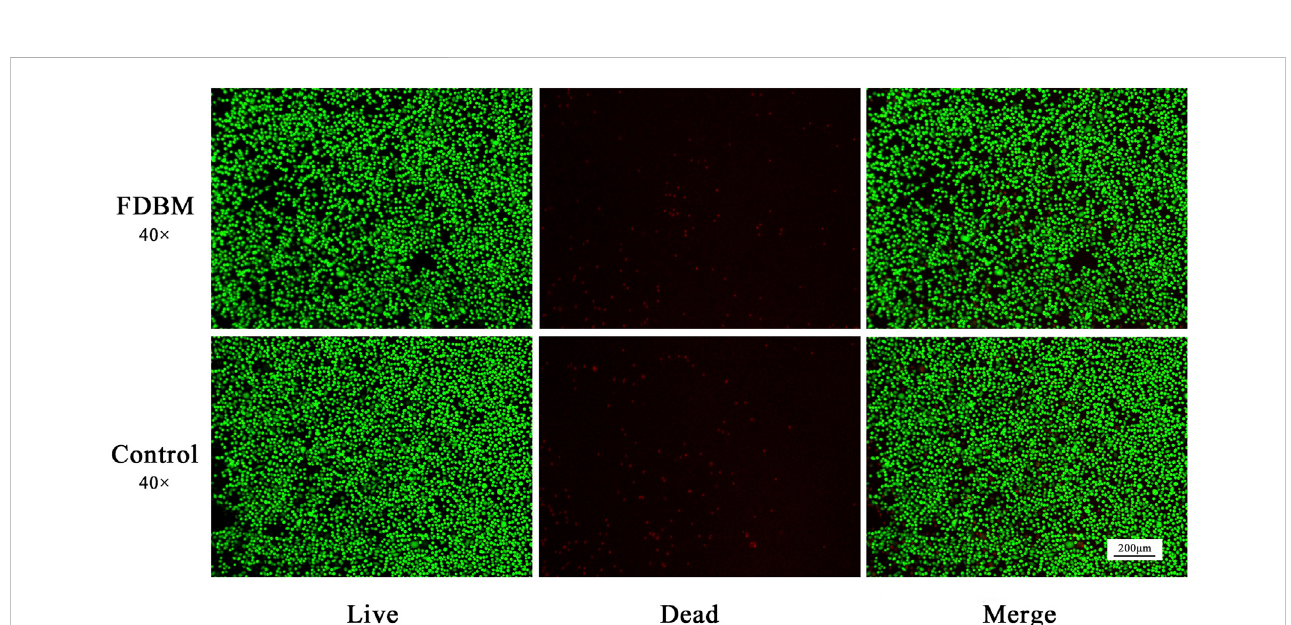
FIGURE 5 Live-Dead staining of L929 cells cultured by FDBM extraction solution after culturing for 3 days (green for living cells and red for dead cells; magni fi cation, ×40).